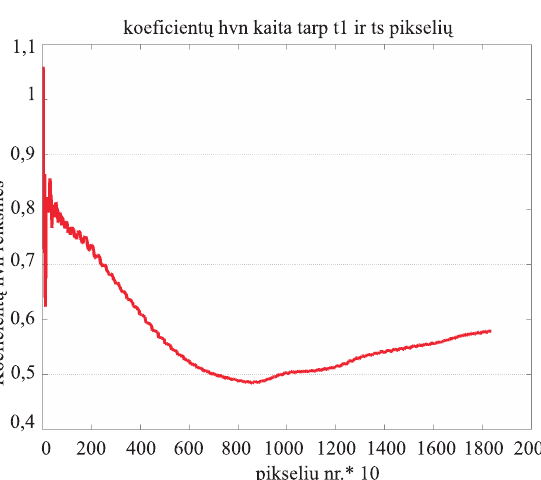
Fig. 7 . Change of the vector covariance coefficient of the healthy human brains from the changes of the distance between vector pixels